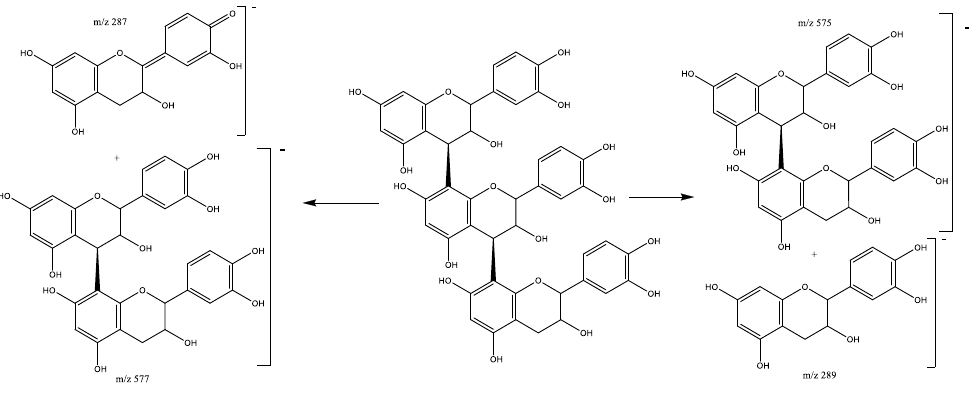
Figure 7. Procyanidin B-trimer fragmentation pathway. Six pure afzelechin B-trimers formed by three (epi)-afzelechins subunits correspond to peaks 5 (Rt = 10.01 min), 29 (Rt = 17.15 min), 37 (Rt = 18.57 min), 39 (Rt = 19.42 min), 43